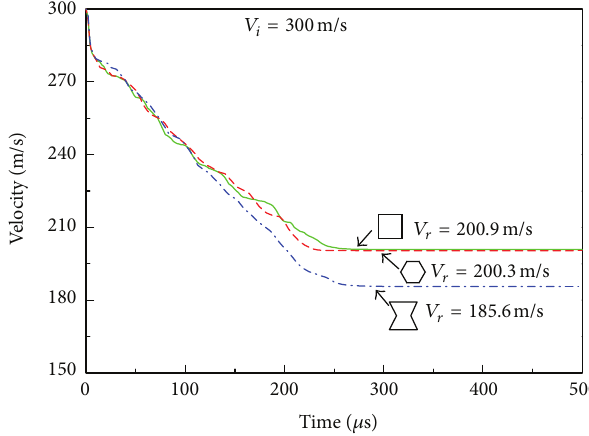
Figure 13: Time history of the transient velocity of the projectile with 𝑉 𝑖 = 300 m/s. Here 𝑉 𝑟 is the residual